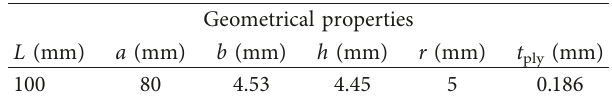
Table 2: Geometry data for 3PB